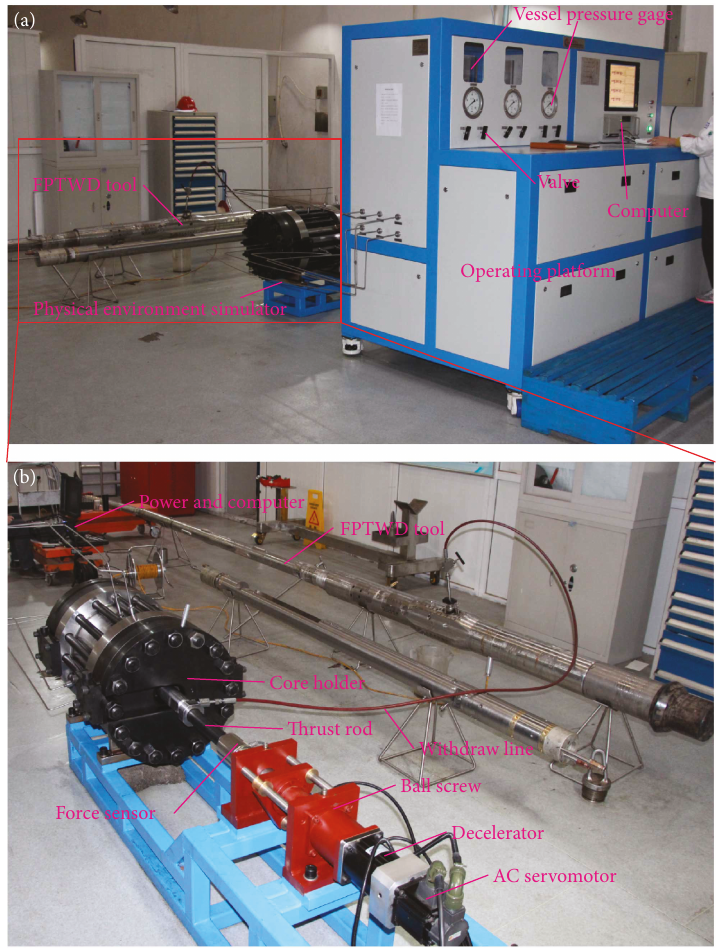
Figure 9: Photos of the physical simulation system for FPTWD. (a) The whole physical simulation system. (b) The physical environment simulator with a real withdrawn system of a FPTWD